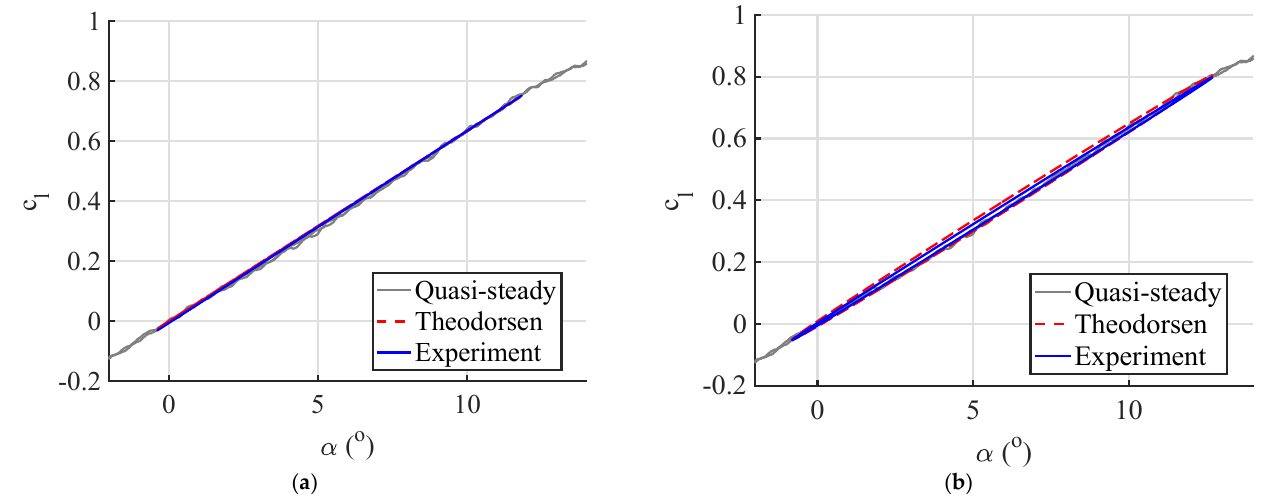
Figure 11. Comparison of single sine experiments at 6° offset with the Theodorsen and quasi-steady results at ( a ) k = 0.006 and ( b ) k = 0.126 values.